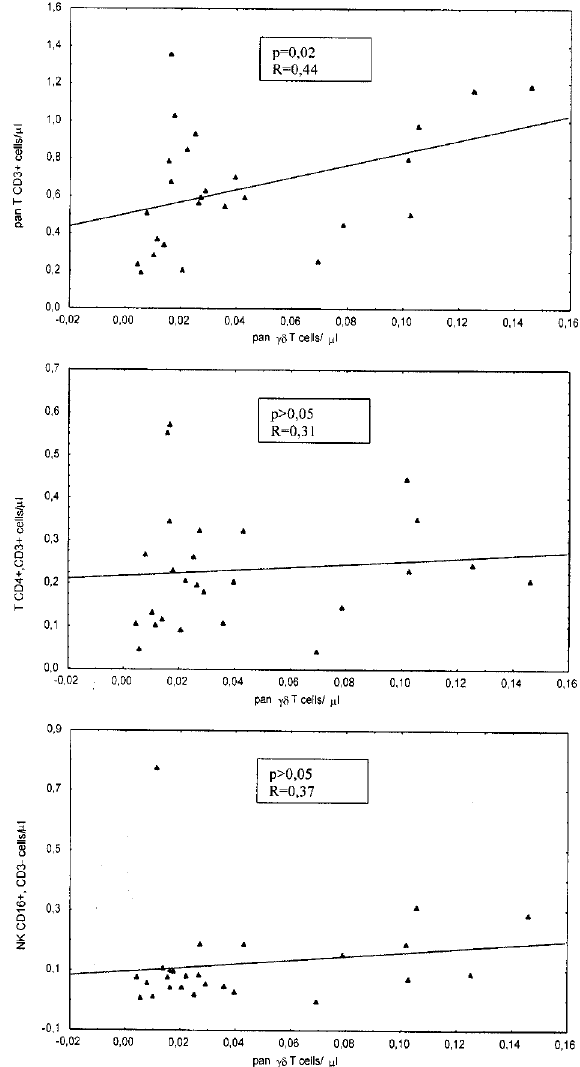
FIG. 2. Correlations between the number of pan g d + T cells and the number of CD3 + , CD4 + and NK cells in peripheral blood of SLE